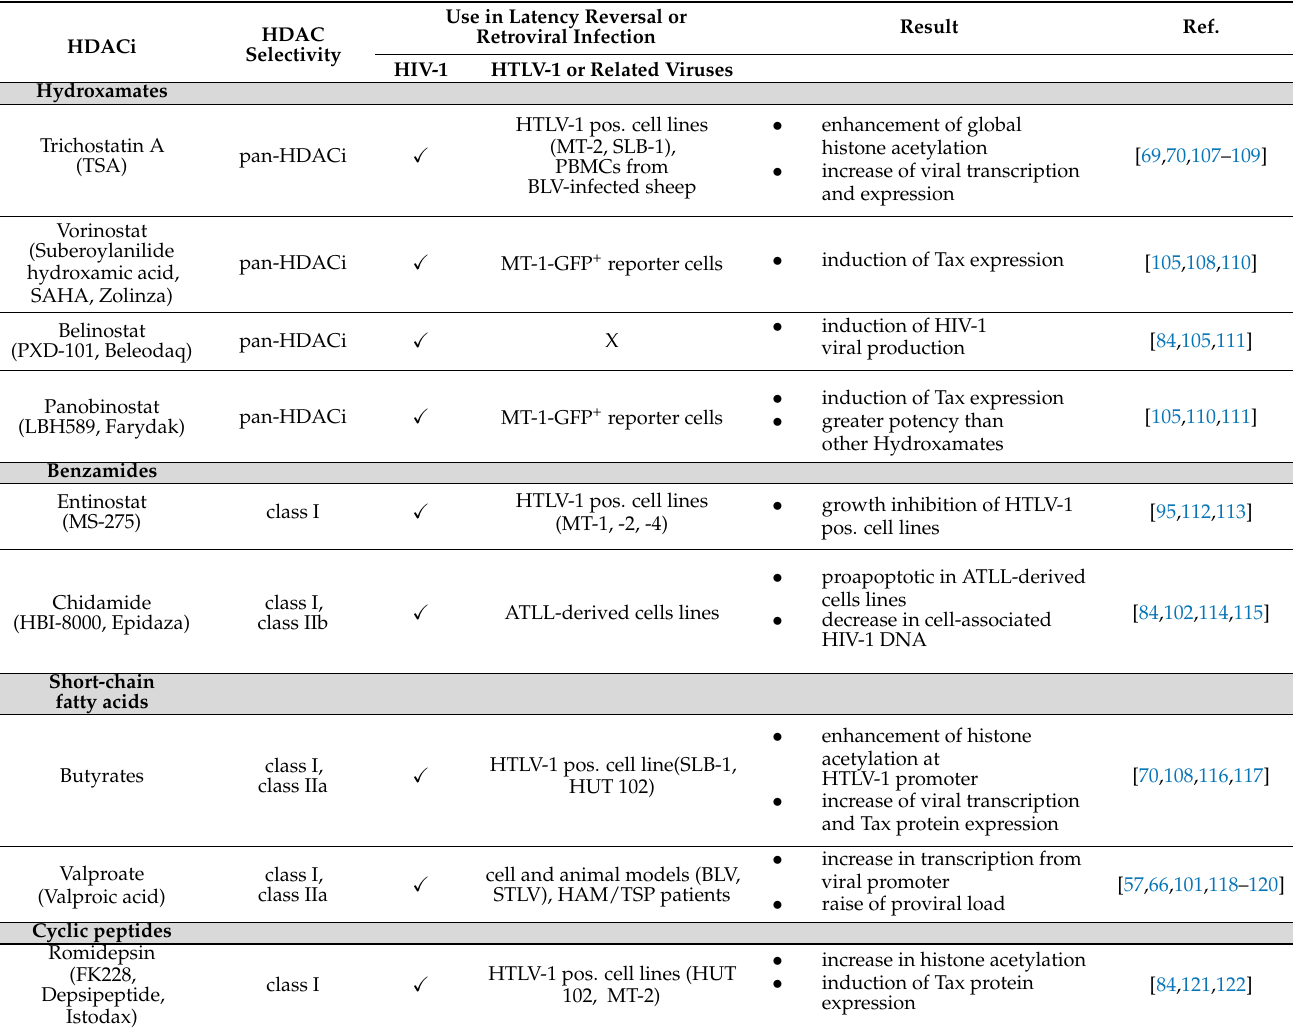
Table 1. Different HDACi that reverse retroviral